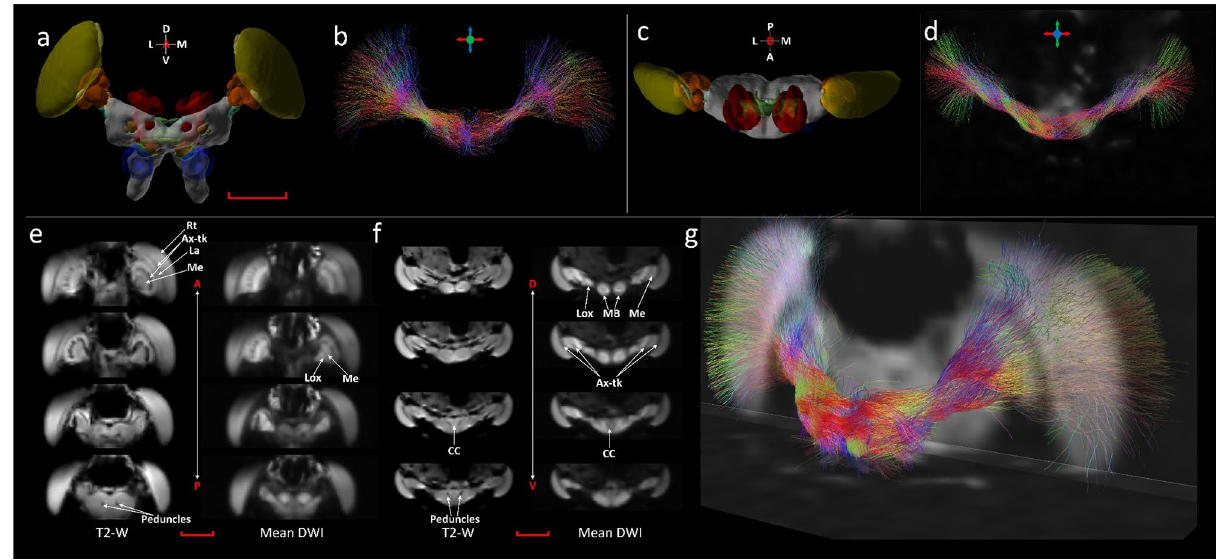
Figure 1. Anatomical regions and tract connectivity derived from dMRI in a live locust. ( a ) Anterior view of 3D anatomical representation taken, with permission, from http://insec tbrai ndb.org 44 . ( b ) 3D projections of directionally encoded tracts from synaptic neuropils (coronal slice, anterior view). ( c ) Dorsal view of 3D anatomical representation taken, with permission, from http://insec tbrai ndb.org 44 . ( d ) 3D projections of directionally encoded tracts from synaptic neuropils (axial slice dorsal view). ( e ) Coronal slice (anterior to posterior view) using T2-W and averaged DWI based contrasts. ( f ) Axial slice (dorsal to ventral view) using T2-W and averaged DWI based endogenous contrasts. ( g ) 3D view of axonal tract projections from synaptic neuropils. In ( b ) and ( d ) coloured crosshairs highlight the direction of tracts. In ( e ) and ( f ) T2-W maps, regions with longer transverse relaxation (T2-relaxation) are hyperintense and regions exhibiting shorter transverse relaxation are hypointense. In averaged DWI based maps, regions of low diffusivity are hyperintense and